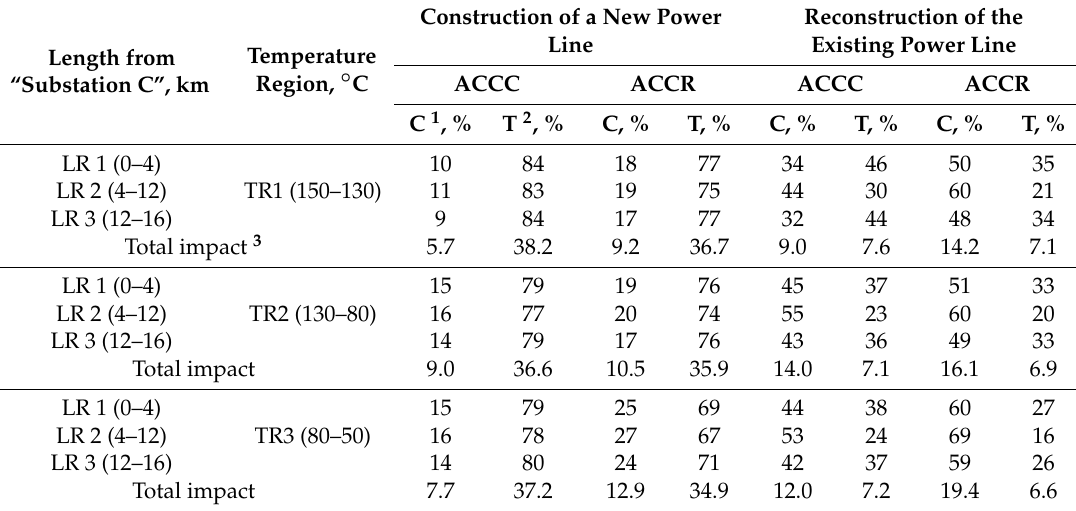
Table 11. Comparison of the effects of two main components on the total material cost and up-front